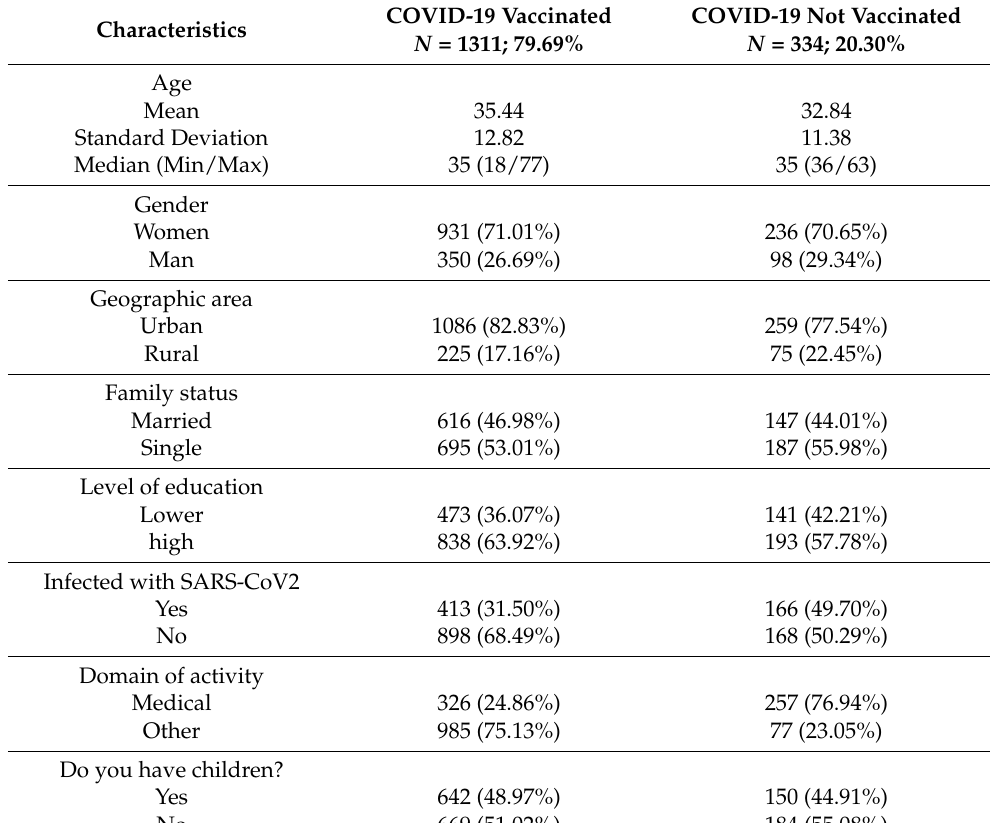
Table 6. Characteristics of COVID-19-vaccinated and non-vaccinated participants in the survey.